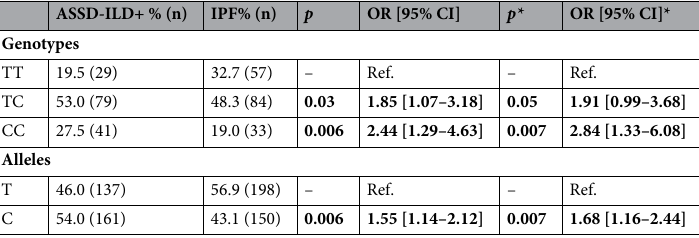
Table 3. Genotype and allele frequencies of MUC1 rs4072037 in ASSD-ILD+ and IPF patients. ASSD: antisynthetase syndrome; CI: confidence interval; ILD: interstitial lung disease; IPF: idiopathic pulmonary fibrosis; OR: odds ratio. Statistically significant results are highlighted in bold. *Adjusted for age and sex.